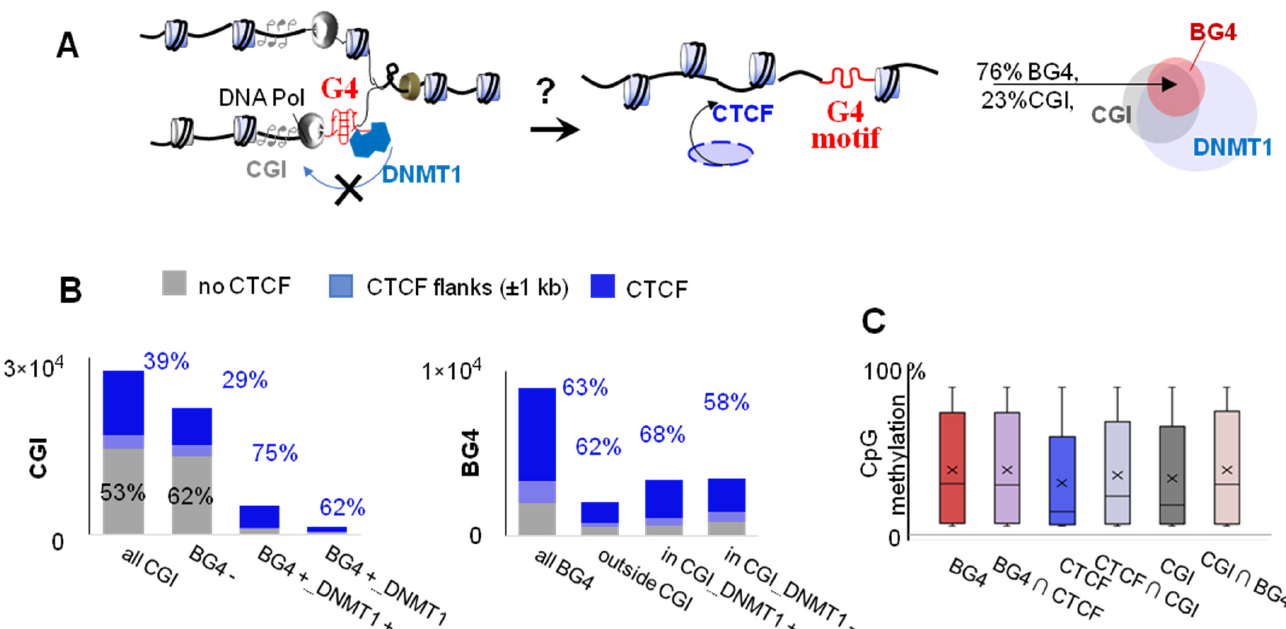
Figure 5. Verification of G4 contribution to the link between CpG islands (CGIs) and CTCF recruitment. ( A ) Hypothetical schemes summarizing the link between G4s, CTCF and CGI methylation: G4s are enriched in CGIs and supposedly protect CGIs from methylation by inhibiting DNMT1, which is favorable for CTCF binding. ( B ) Intersections of CTCF peaks with various subsets of CGIs and BG4 peaks. ( C ) Analysis of average CpG methylation levels in CpG-containing BG4 peaks, CTCF peaks, CGIs and their intersections in K562 cells.